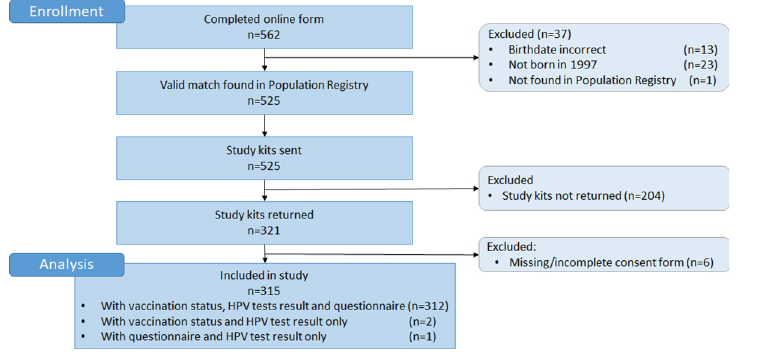
Fig 1. CONSORT flow diagram of the study